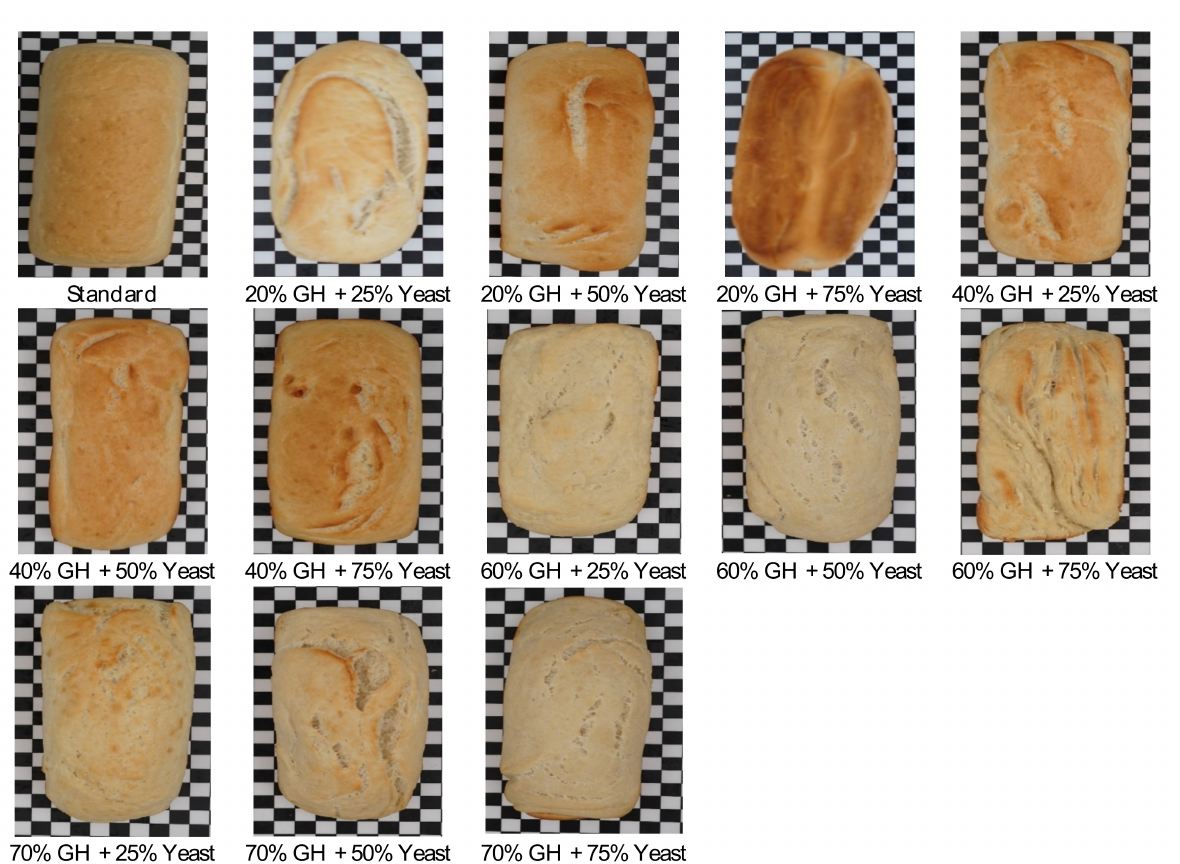
Figure 2. Pictures of GH bread with promoters (20%, 40%, 60%, and 70% GH) and partial replacement (yeast 25%, 50%, and 75%). Different percentages of yeast along with different percentages of GH were used to prepare the bread. It was found that application of yeast along with GH increased the volume of the